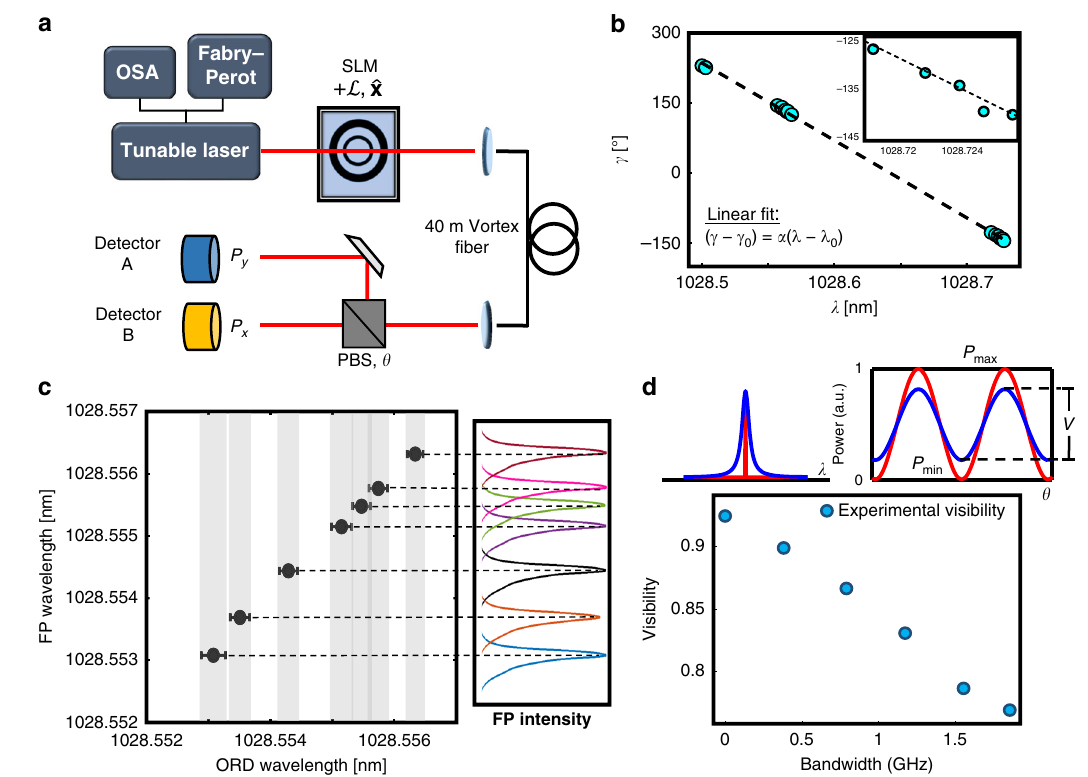
Fig. 2 ORD wavemeter performance. a A SLM generated b x -polarized OAM superposition state experiences OA through 40 m of vortex fi ber. At the output, a PBS splits power into two orthogonal polarization bins ( b x , b y ), and the ratio of powers, ( P x , P y ) instantaneously determines polarization orientation angle γ (see Methods). b Calibration of ORD birefringent strength ( α ) is necessary to accurately map λ to γ . Wavelength sweep Δ λ , resolved using